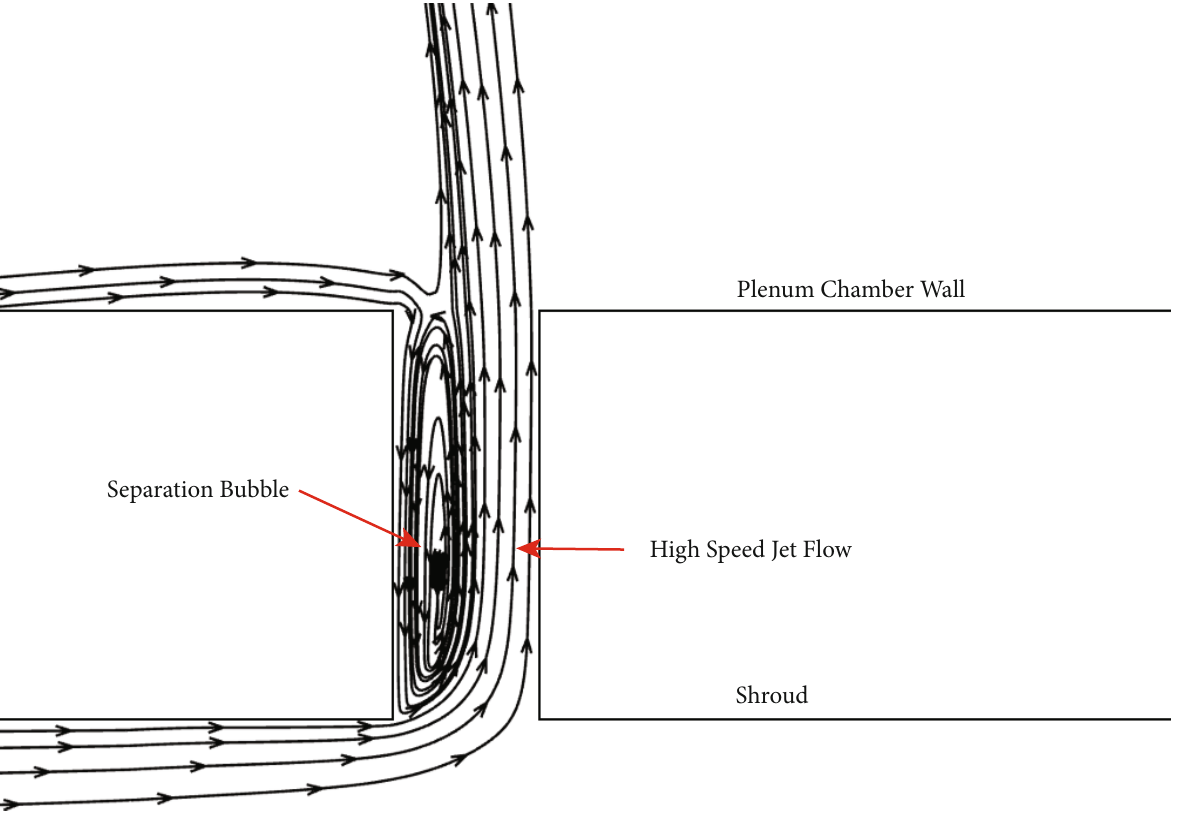
Figure 9: Flow diagram in slot with medium bleed rate.